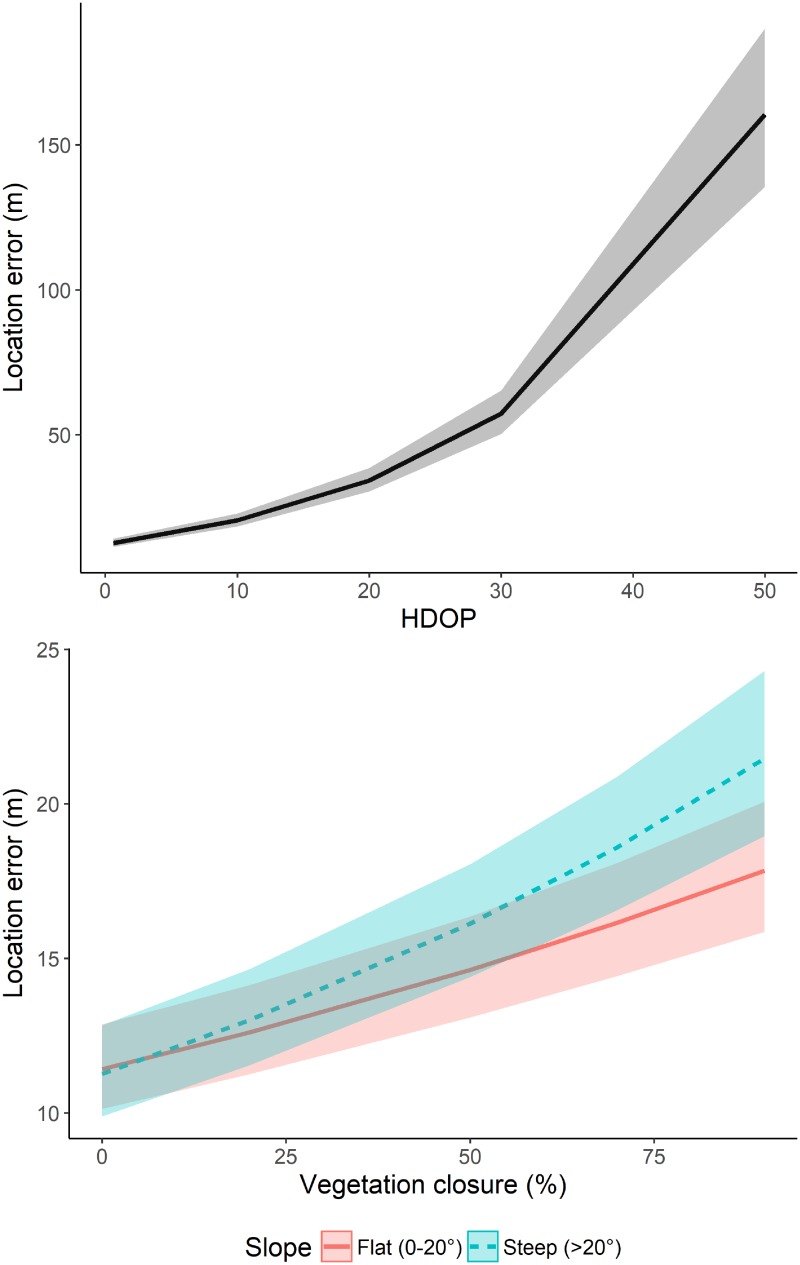
The effect of horizontal dilution of precision (HDOP, upper graph) and the interaction of canopy closure x slope (lower graph) on the location error of GPS receivers during stationary tests.Slope was categorized into ‘flat’ (0–20°) and ‘steep’ (> 20°) for reasons of better visualization.